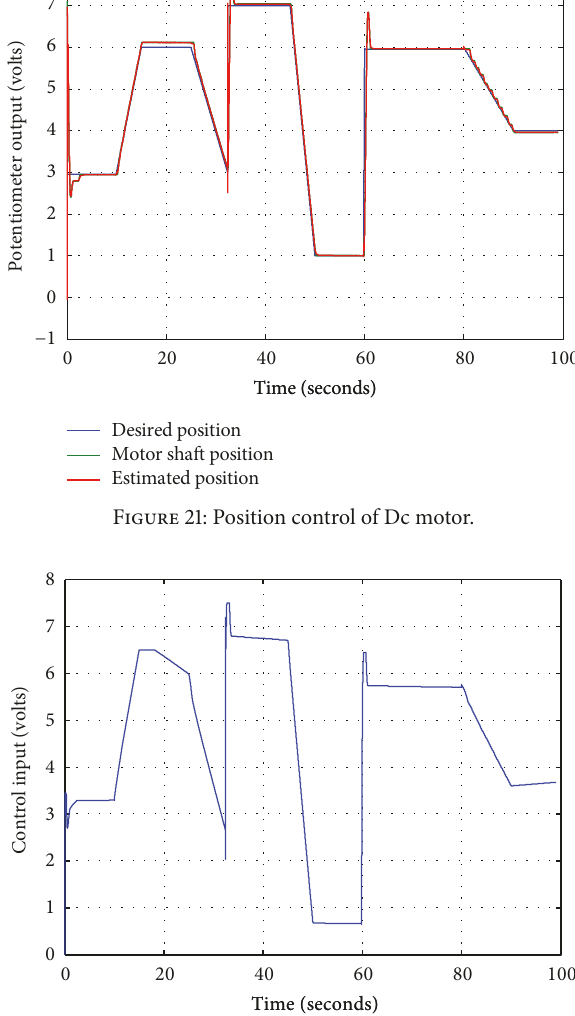
Figure 22: Control input to position control